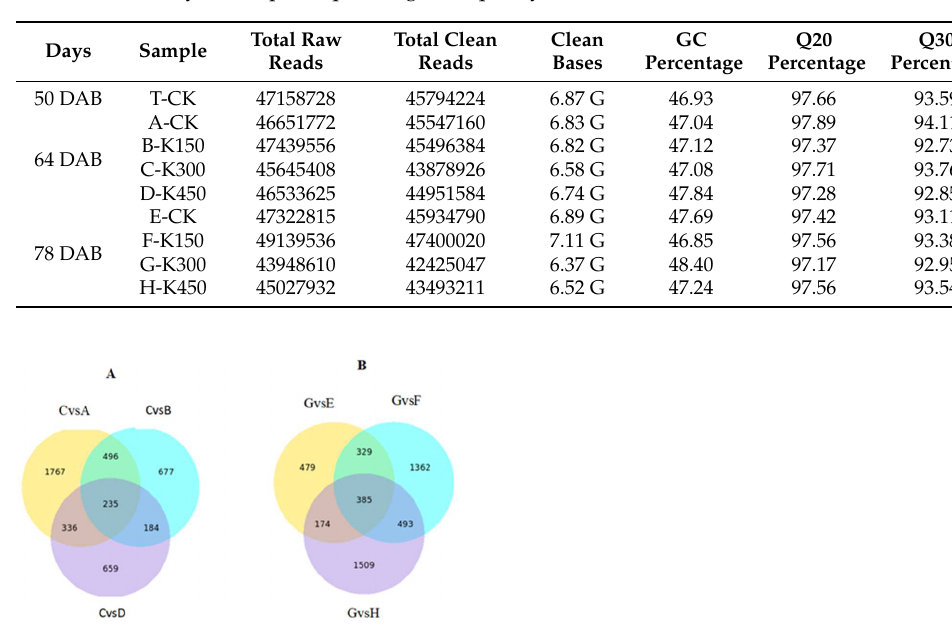
Figure 7. Venn diagram of differentially expressed genes. ( A ): Venn diagram at 64 DAB. ( B ): Venn diagram at 78 DAB. ( p < 0.05 and fold change equal or greater than 2). 2.9. Functional Classification of DEGs To analyze the function of genes’ different expressions in response to K at 78DAB, the DEGs were enriched with Gene Ontology (GO). The top 20 GO enrichment entries for abundance are shown (Figure 8). In the classification of biological processes, DEGs are mainly enriched into items such as metabolic processes and cellular processes. In the cell composition, it is mainly enriched into membranes, cells, etc. In molecular functions, it mainly includes catalytic activity, binding, and ion transport activity. The KEGG analysis showed that there was significant enrichment of DEGs in several important biological